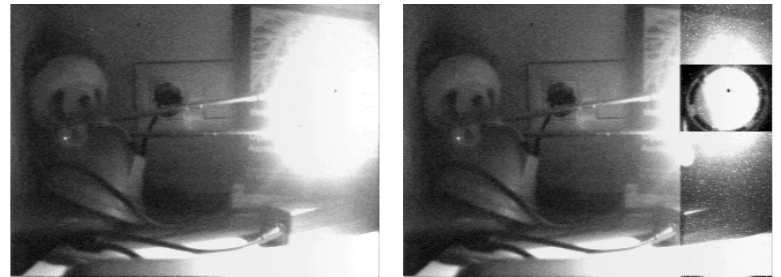
Figure 10. On-chip block-wise intra-frame integration time control. Global control of the integration time is applied to the left image. In the right image, the integration time of the region around the center of the lamp adjusts locally and asynchronously to its mean